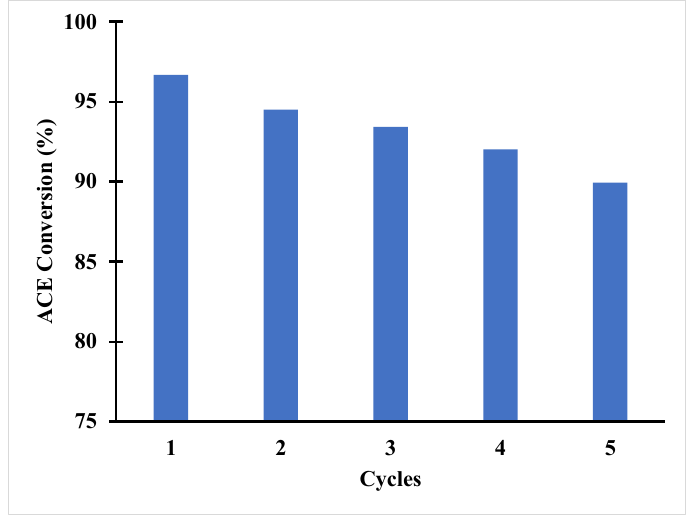
Figure 10. Effect of recycling of the Pd ‐ GO ‐ ZnO photocatalyst on acetamiprid conversion. Catalyst loading = 0.2 g/L; C 0 = 15 mg/L; Temperature = 25 °C; Reaction time = 4 h.